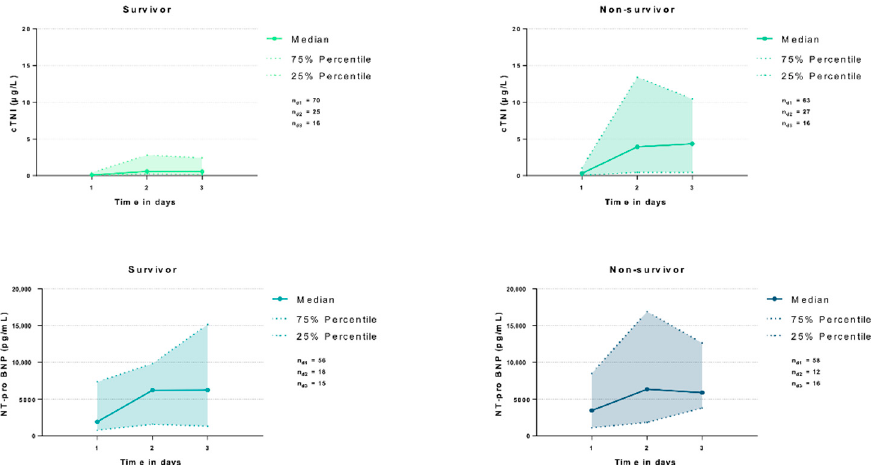
Figure 3. Distribution of cTNI and NT-pro BNP among patients on days 1, 2 and 3, comparing 30-day survivors and non-survivors.